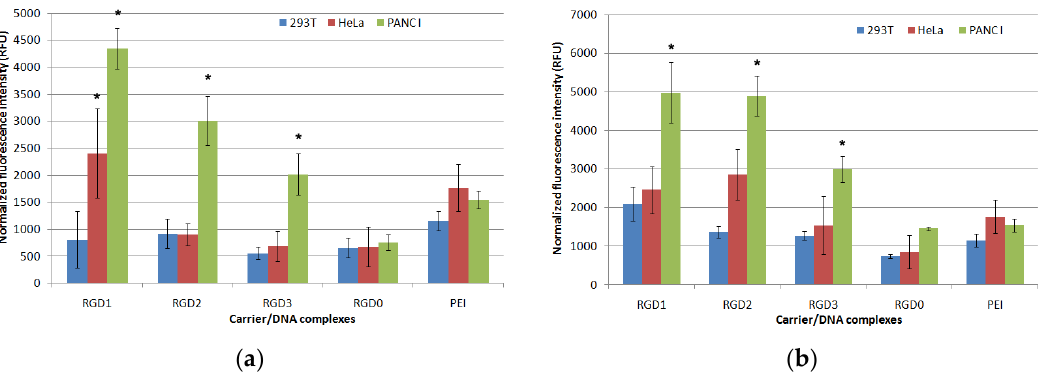
Figure 7. Normalized fluorescence intensity of PANC-1, HeLa and 293T cells after uptake of RGD1/DNA, RGD2/DNA, RGD3/DNA and RGD0/DNA polyplexes at 8/1 ( a ) and 12/1 ( b ) charge ratios labeled with YOYO-1. * p < 0.05 compared to RGD0/DNA complexes.